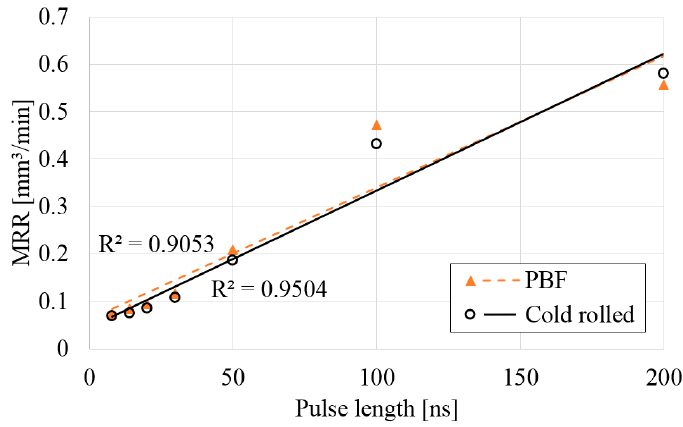
Figure 7. Material removal rates for holes laser drilled in PBF and cold rolled sheets.